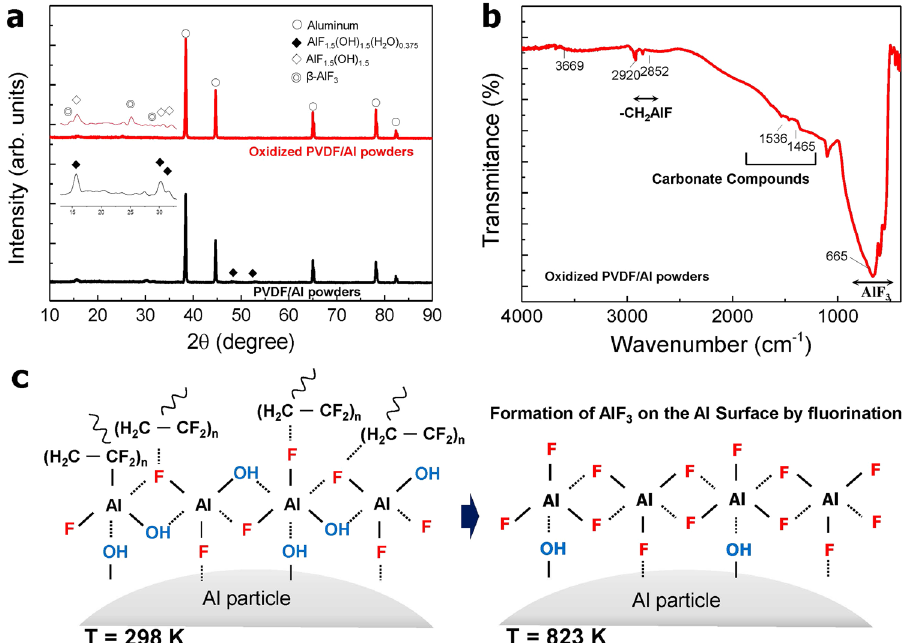
Figure 4. ( a ) X-ray diffraction patterns of the PVDF/Al powder before and after an oxidation treatment at 823 K, ( b ) transmission FT-IR spectrum of oxidized PVDF/Al powder, and ( c ) depictions showing fluorination by thermal